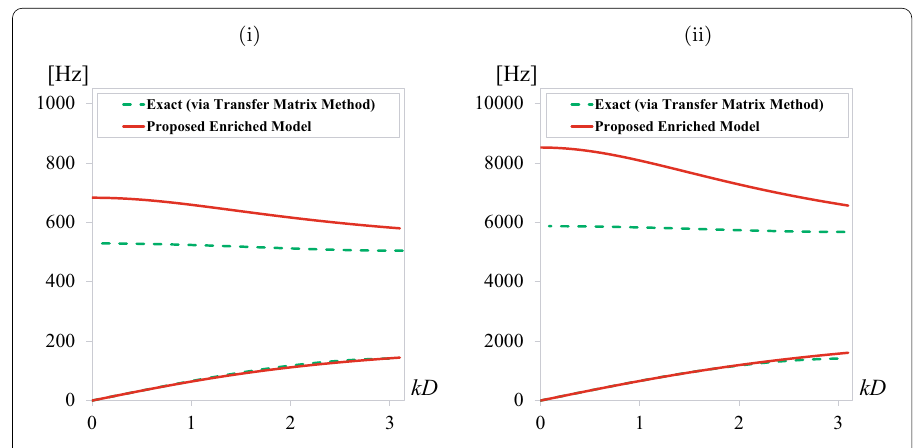
Fig. 6 Dispersion analyses of un-relaxed (elastic) cases pertaining to relaxation time [A] ( κ = ∞ ) in compliant layer for i Metamaterial 1, ii Metamaterial